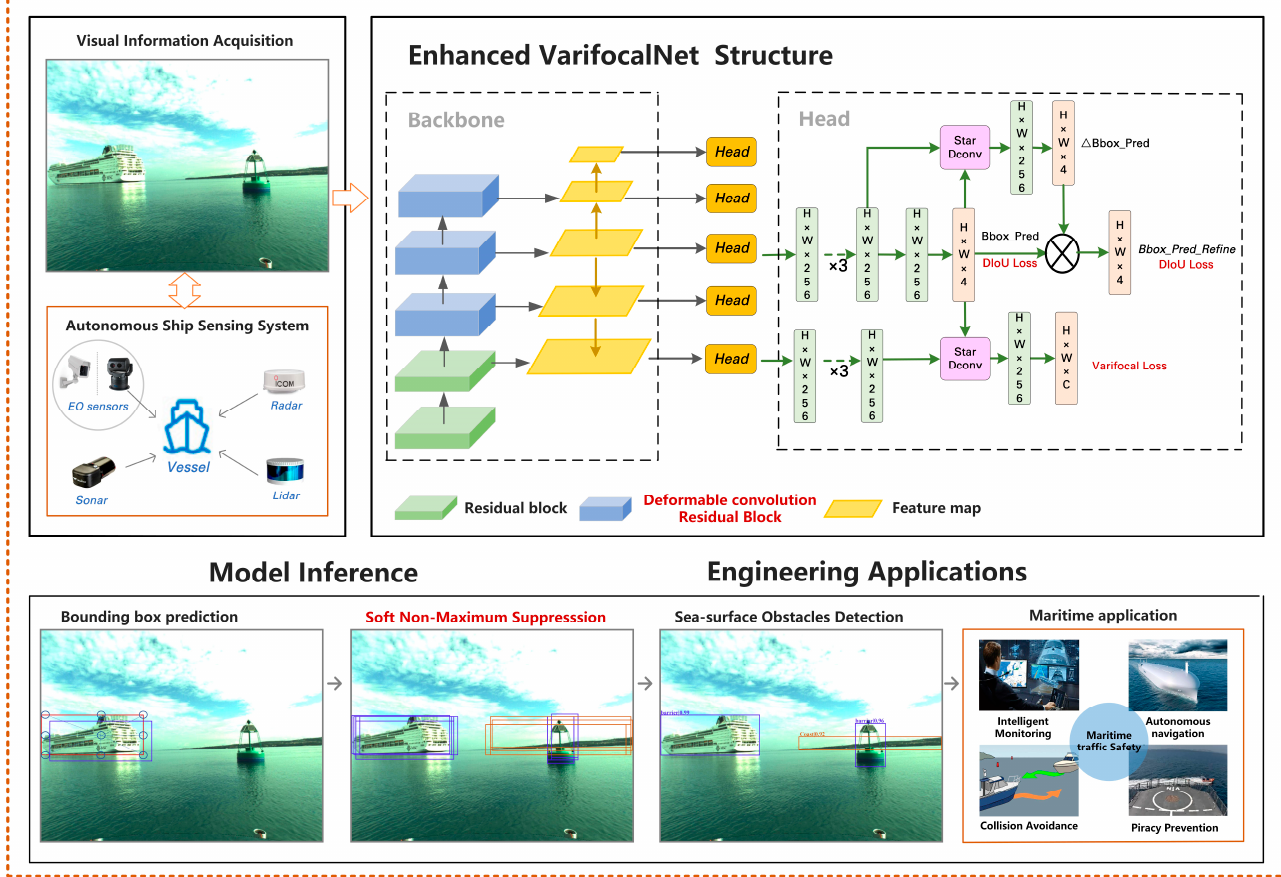
Figure 1. Flowchart of CNN-based maritime obstacle detection framework. To improve the object feature extraction ability, we use ResNet50 in the backbone part of the network, in which the last three traditional residual blocks are replaced by deformable convolution residual blocks. The feature map part uses feature pyramid network. In addition, the learning ability of the network is further improved by redesigning the loss function, introducing soft non-maximum suppression, and adopting multi-scale forecasting